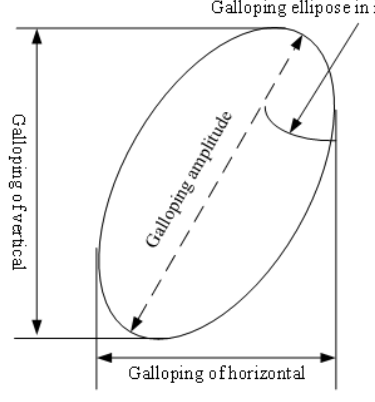
Figure 2. The galloping trace.